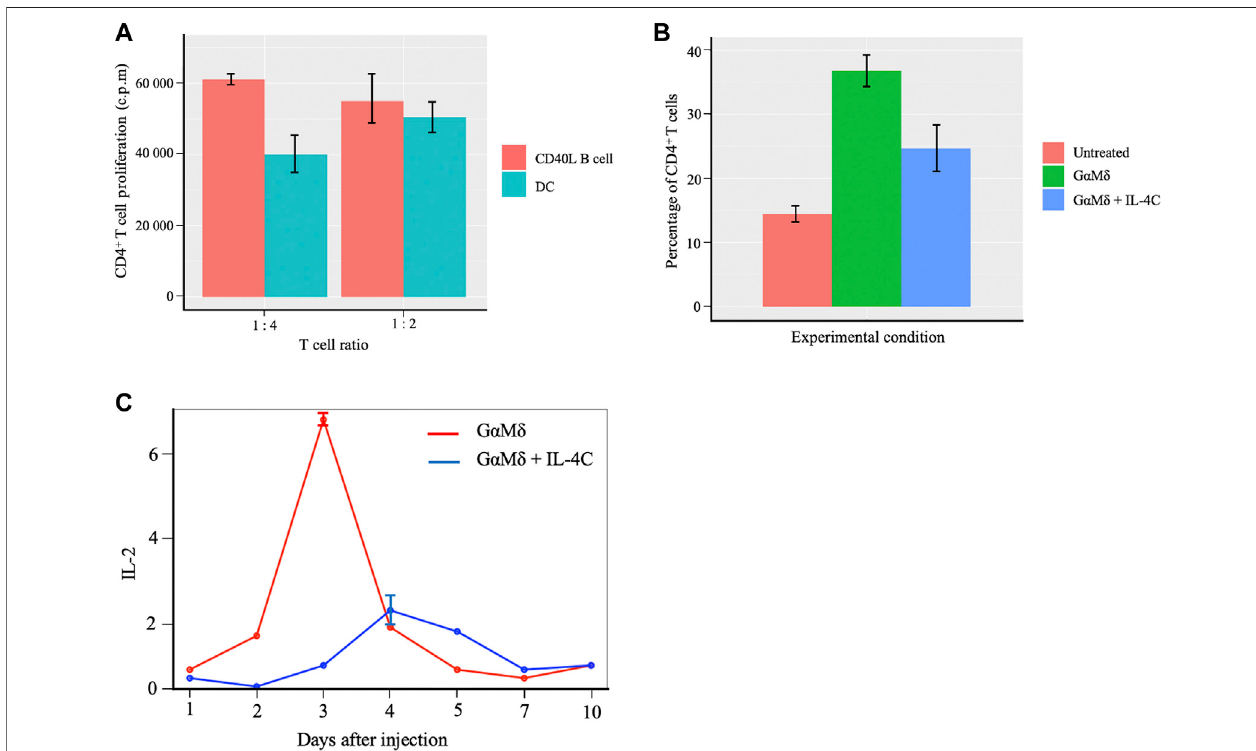
FIGURE7| ProliferationofCD4+TcellswithBcellsandDCsactivationofthenaïveTcellsandeffectsofcytokinesIL-2andIL-4onTcellsproliferation. (A) Barplots showing comparable effects of Murine CD40L-activated B cells to mature dendritic cells (DC) in peptide presentation to CD4+ T-cell clones. Data obtained from independent cultures of APC are presented as means ± SE. The CD4+ T-cell clones were cultured in the presence of APC. (B) Barplots showing differences in percentagechangeofCD4+Tcellsbetweenthreeconditions;BALB/cmicewereleftuntreated(Untreated),BALB/cmiceinducedwithIL-4Csignalingandinjected with antigen and mice only injected with antigen alone. IL-4C inhibits G α M δ induction of CD25 expression by CD4+ T cells. Representative barplots are shown for the fl uorescenceofCD25onCD4+TcellswhichrepresentmeansandSEforpercentagesofCD4+cellsthatexpressCD25.AhigherCD4+Tcellproductioninthepresence and absence of IL-4C stimulation is observed compared to the untreated condition. (C) Curves showing the inhibition of IL-4C gene expression of IL-2 under two conditions. In the fi rst scenario, BALB/c mice were injected with 800 μ g of G α M δ on day 0 (G α M δ treated). In the second condition, BALB/c mice were injected